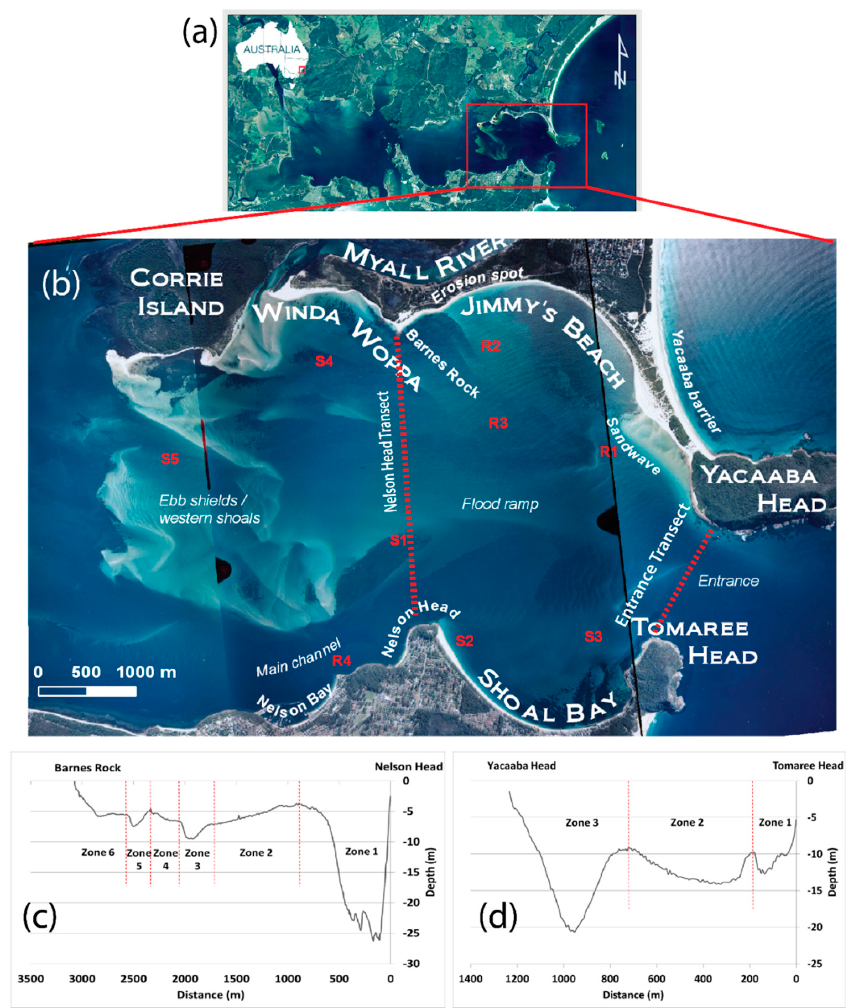
Figure 1. Location of Port Stephens: ( a ) Port Stephens is located in the mid-north coast of New South Wales on the east coast of Australia and has two basins separated by a narrow constriction; ( b ) detail on the outer (eastern) basin showing the geomorphic units mentioned in this paper, the locations of the Acoustic Döppler Current Profiler (ADCP) deployments (R1–R4 and S1 to S5) and the two transects used to the boat-mounted ADCP transects, the Nelson Head Transect, over the FTD, and the